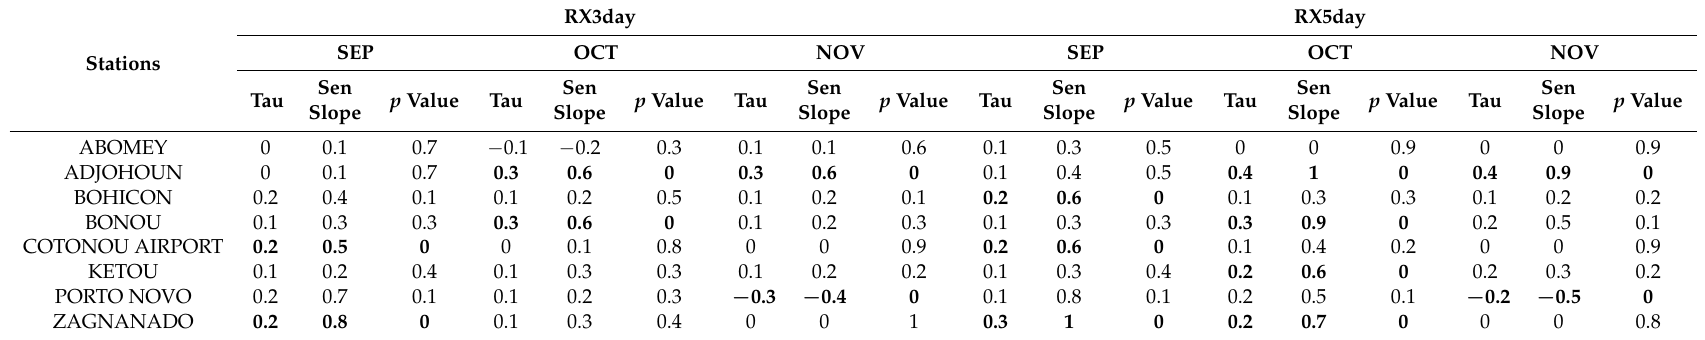
Table 8. Monthly trend analysis of three-day precipitation amount (RX3day) and five-day precipitation amount (RX5day) during high